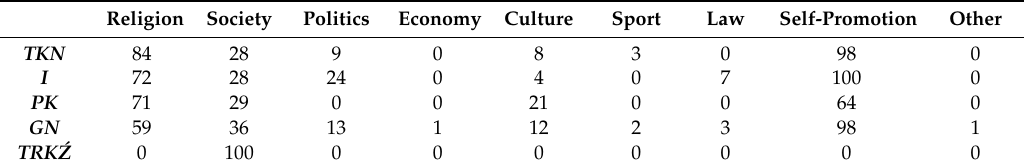
Table 11. Post topics (%).